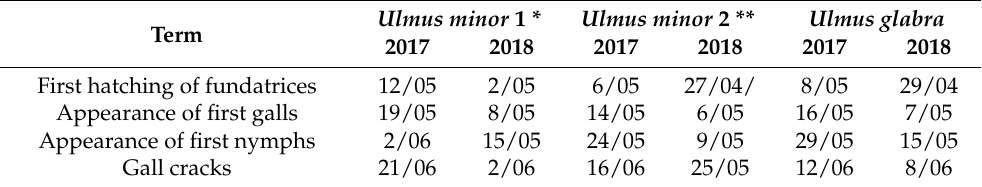
Table 2. Timetable of fundatrix hatching and appearance of the galls and nymphs of T. nigriabdominalis on U. minor and U. glabra (day/month).